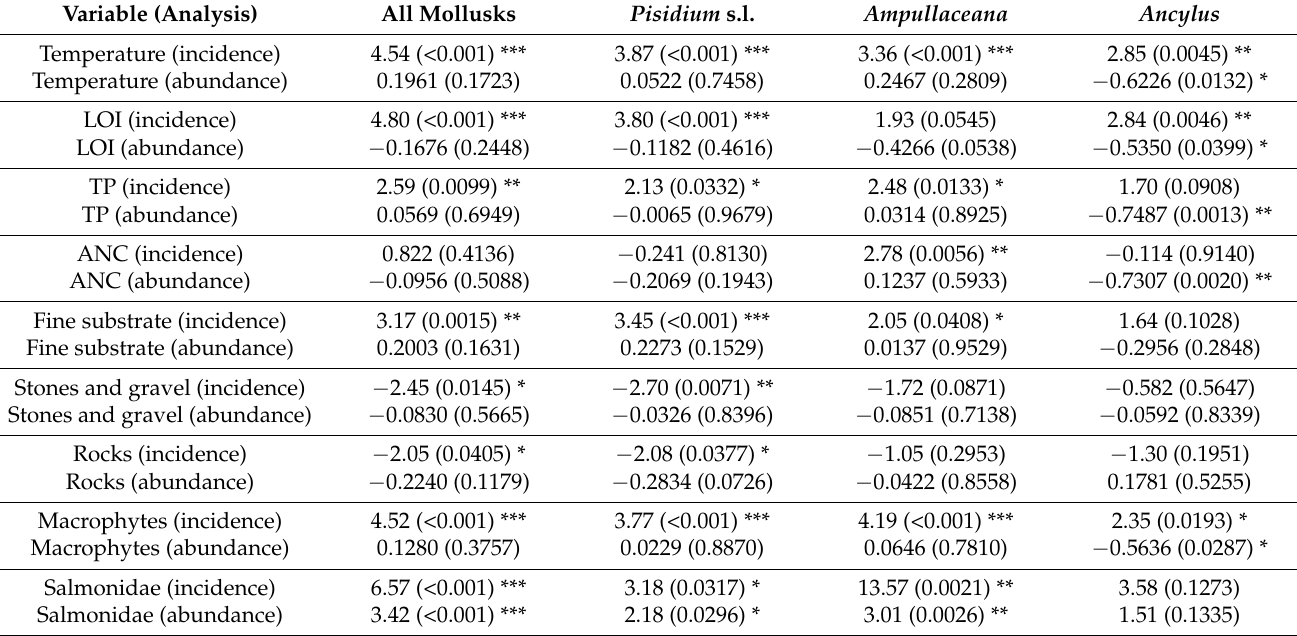
Table 3. Relationship between incidence and abundance of mollusks and environmental